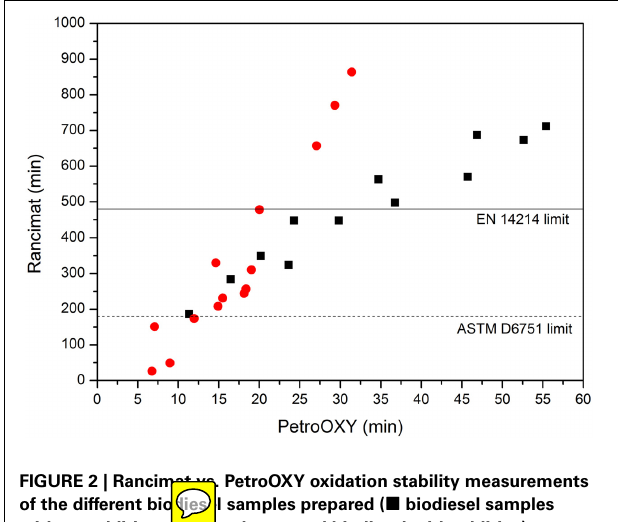
without additive, • soy and rapeseed biodiesel with additive).